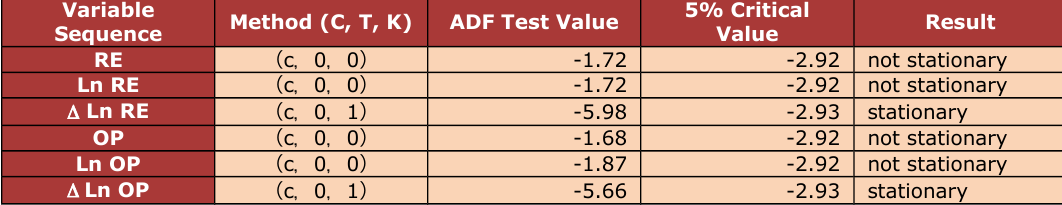
Table 2. ADF unit root test chart